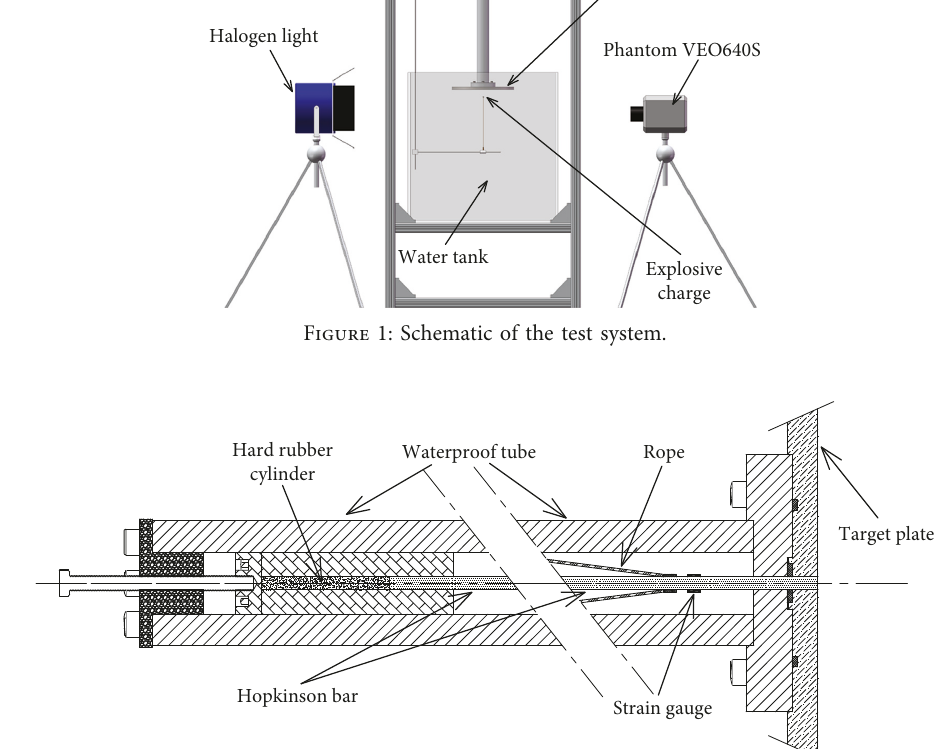
Figure 2: Detailed schematic of the